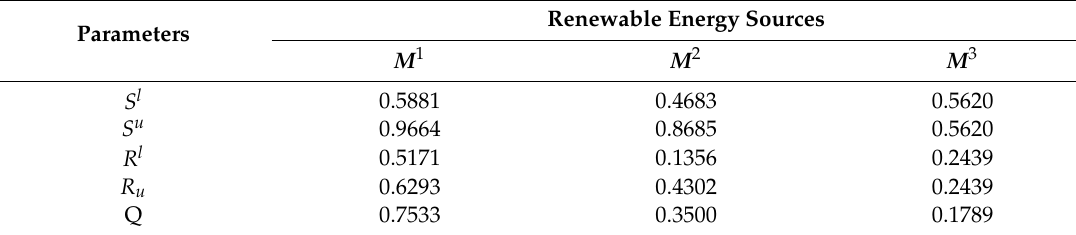
Table 4. Estimation of parameters S, R, and Q under interval context.